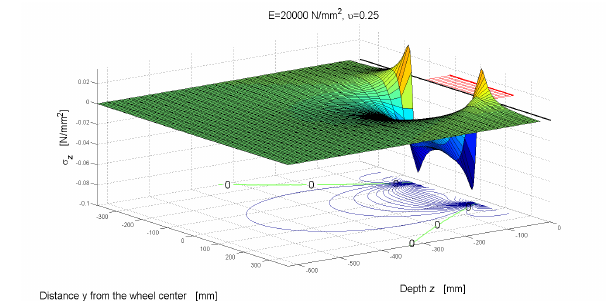
Figure 13: 3-D surface and stress contours of σ z on the A-A vertical cross-section of Figure 11, according to the second order solution.